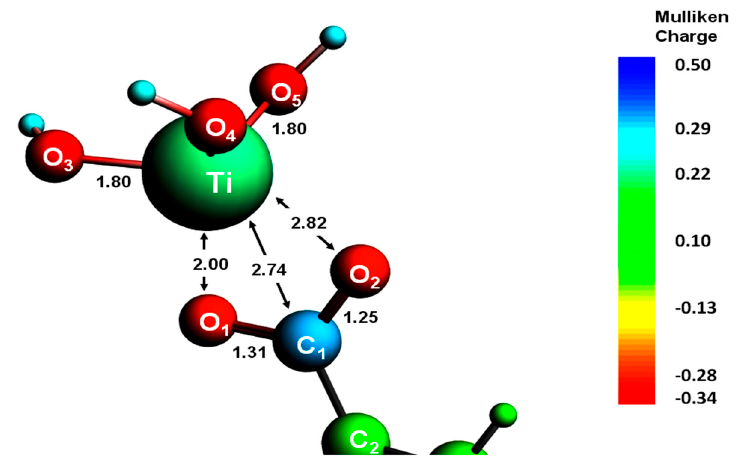
Figure 24. Inter-atomic distances and Mulliken´s charge analysis on the [R-COO-Ti(OH) 3 ] interface.